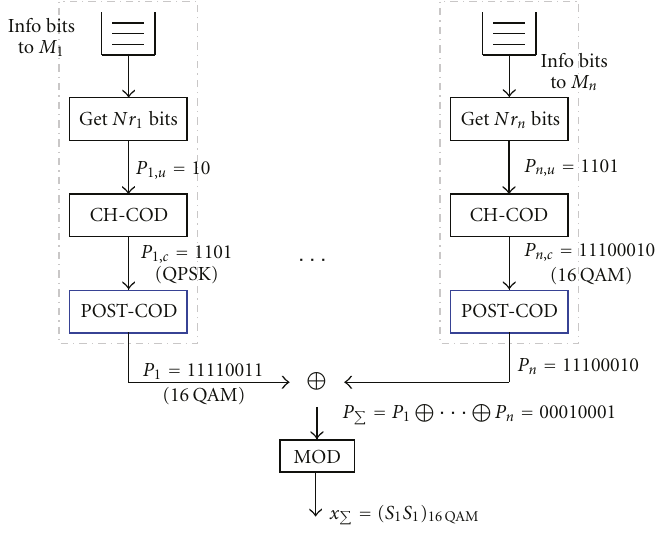
Figure 3: Coding and modulation at the relay node.